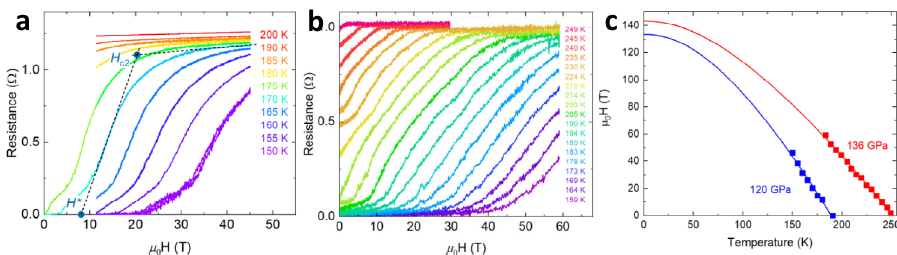
Fig. 3 Resistance of LaH 10 as a function magnetic fi eld at different temperatures. a DC fi eld measurements for the C2/m phase of LaH 10 at 120 GPa. Two dashed lines extrapolate the slope of the high-temperature superconducting transition (left line) toward the asymptotic trace representing the high- fi eld normal state magnetoresistance (right line) at 170 K, respectively. The intersection between two lines provides an estimation of the upper critical fi eld ( H c2 ). The intersection of the fi rst line with the horizontal axis indicates the irreversibility fi eld ( H *) for the high-temperature superconducting phase. b Pulsed fi eld measurements for the Fm-3m phase of LaH 10 at 136 GPa. Both DC and pulsed fi eld traces were recorded under isothermal conditions with no observation of eddy current-generated Joule heating due to the sweeping of the fi eld. c Fits of the superconducting upper critical H c2 to the Werthamer – Helfand – Hohenberg (WHH) formalism. Red and blue squares denote the loci of H c2 of LaH 10 at 136 and 120 GPa, respectively. Lines of the same color correspond to the WHH fi ts of the experimental data. Table 1 Summary of sample properties and the associated WHH fi t parameters: the critical temperature, the upper critical fi eld at T = 0 K, coherence length at T = 0 K, BCS Fermi velocity, calculated bare-band Fermi velocity, and the slope of H c2 at the critical